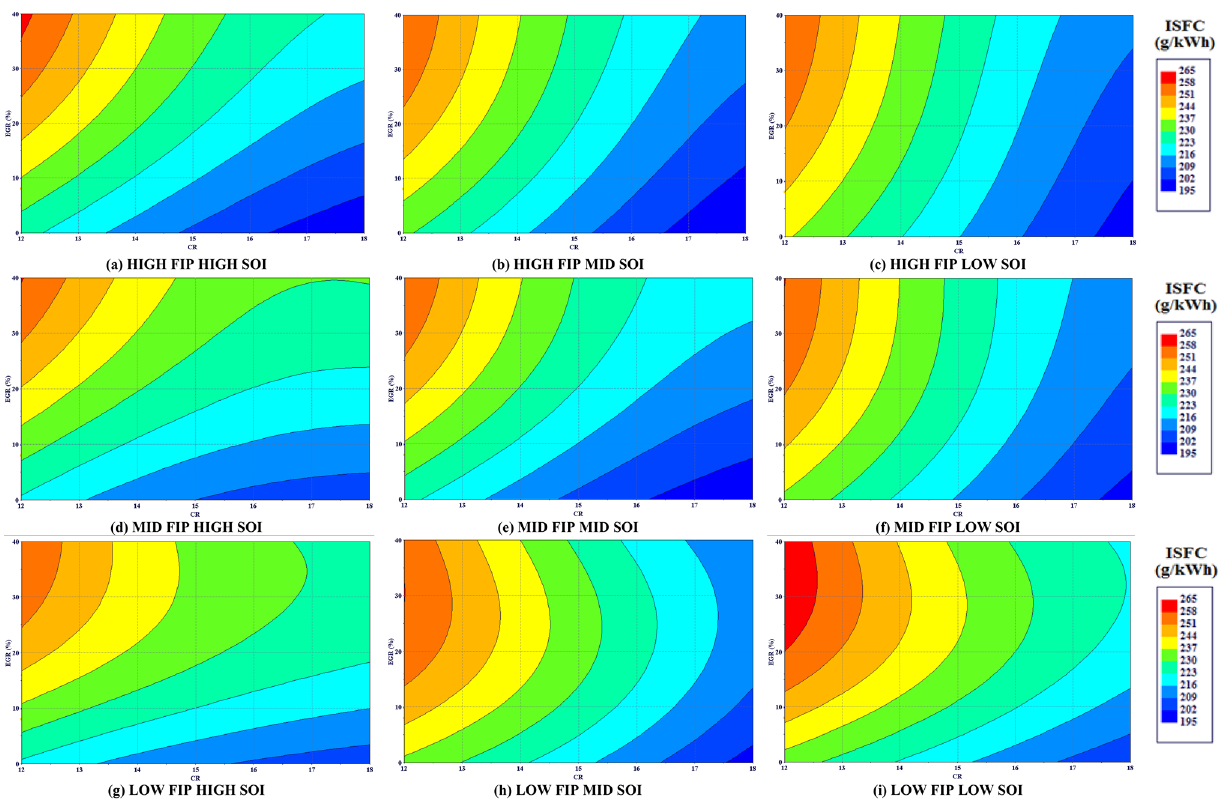
Fig. 3 Contour plots of ISFC for EGR and CR at different levels of SOI and FIP (VCR